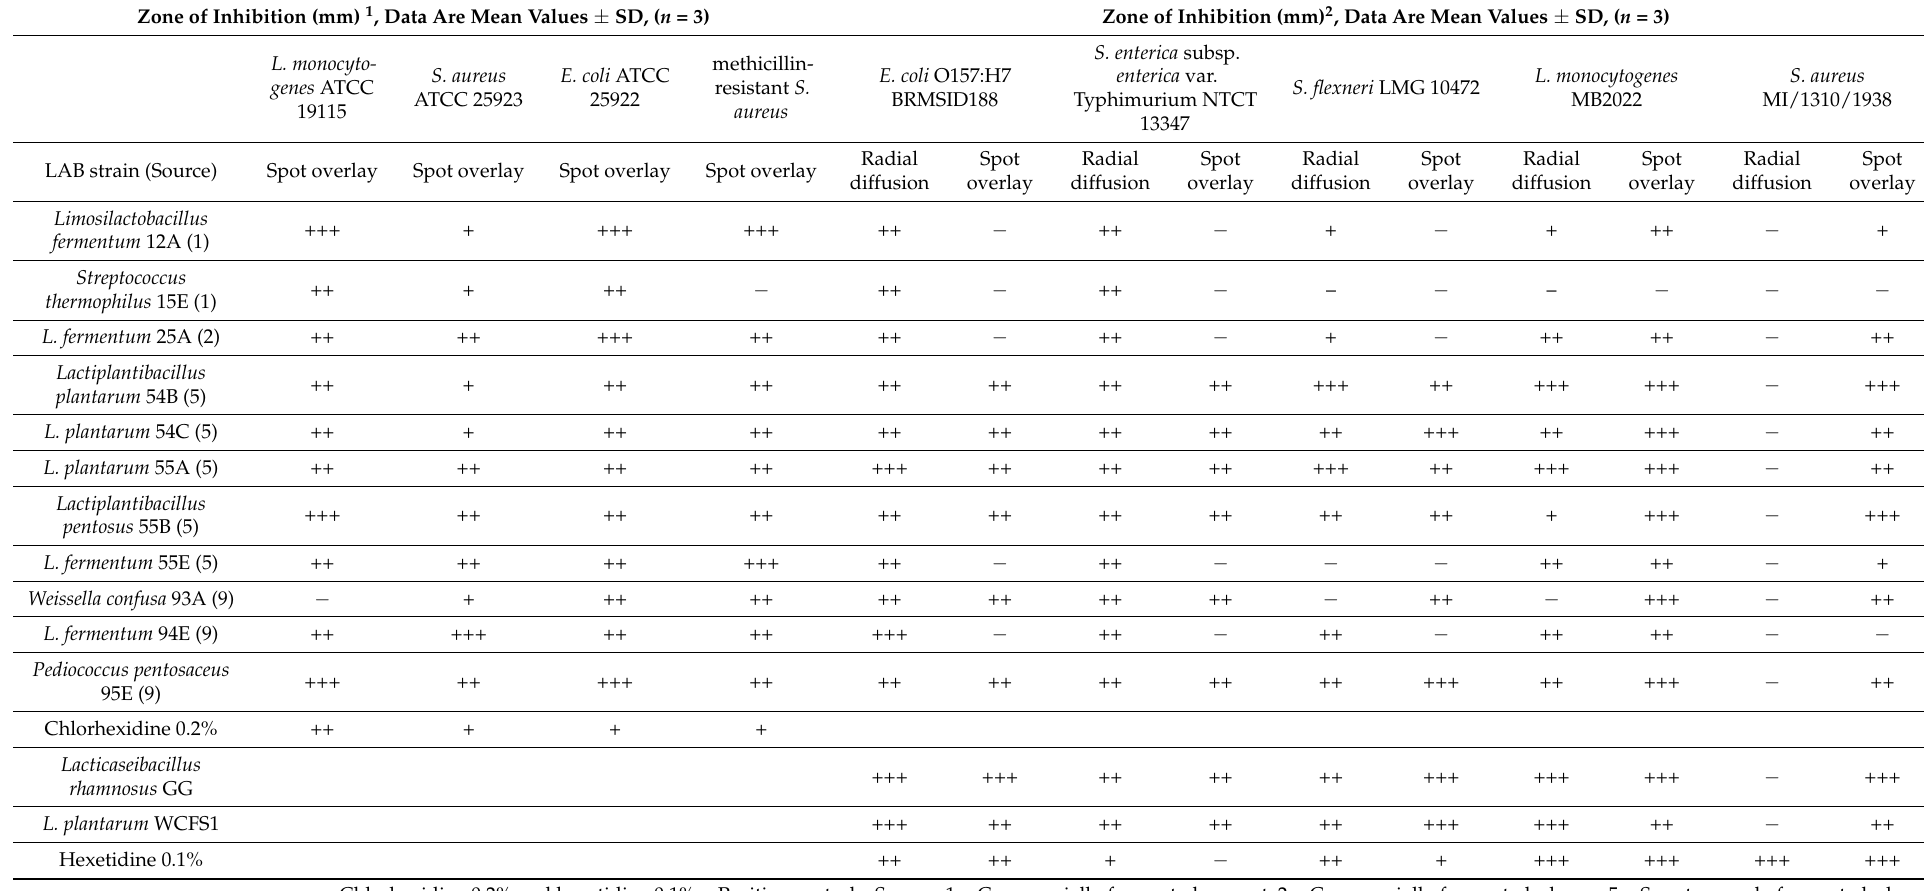
Table 2. Antagonistic activity of the selected potential probiotic LAB strains by spot overlay and radial diffusion methods against 9 strains indicator food- borne